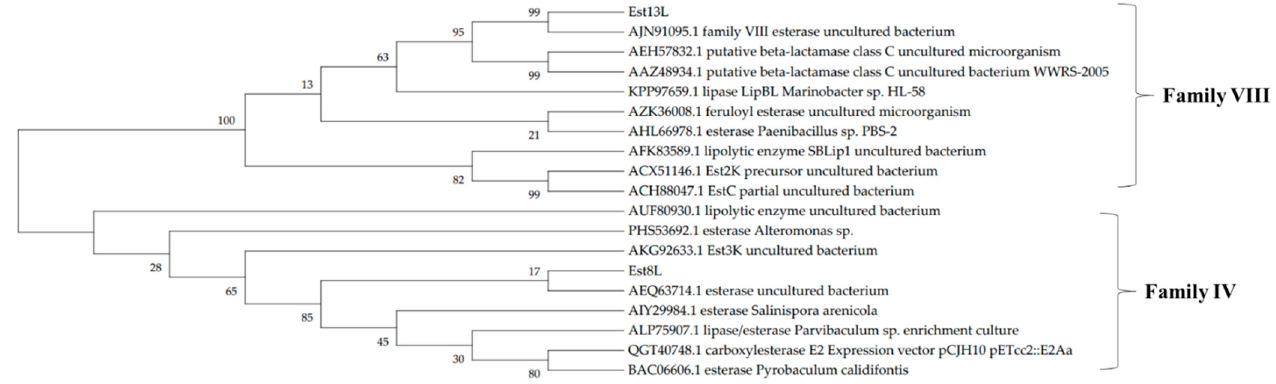
Figure 1. A phylogenetic tree of Est8L and Est13L using the maximum likelihood method. The number at the node shows bootstrap percentages of 1000 replicates. The accession numbers were from GenBank.